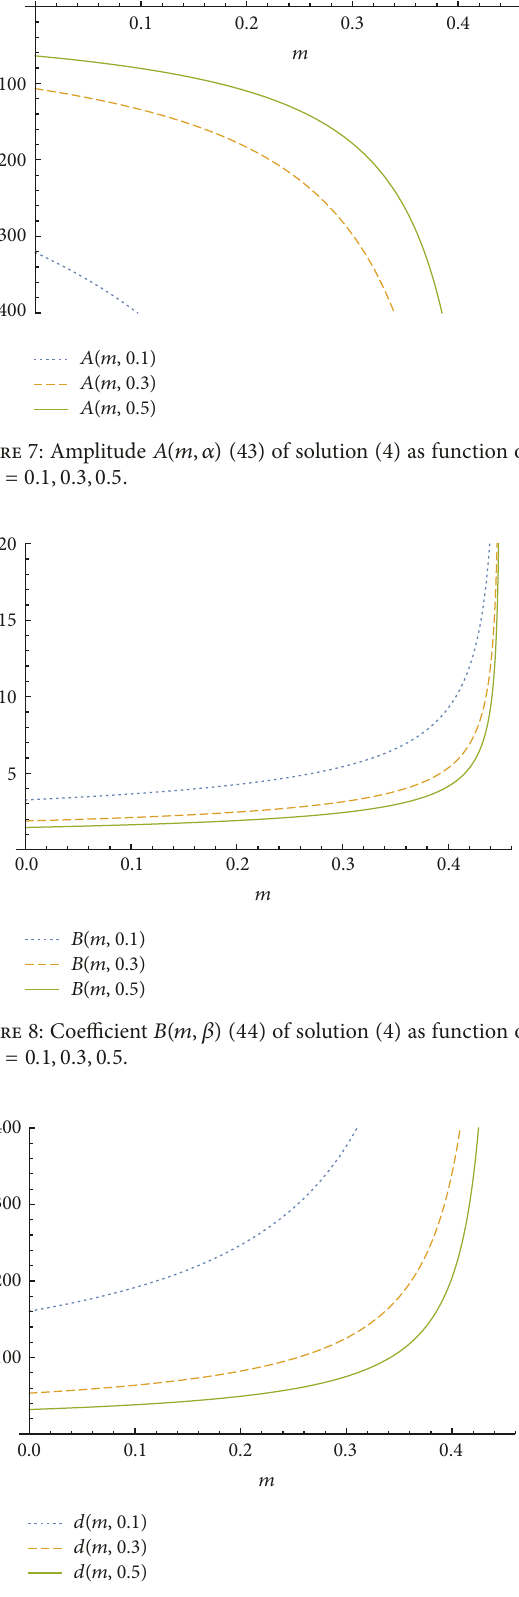
Figure 9: Coefficient 𝐷(𝑚, 𝛼) (45) of solution (4) as function of 𝑚 for 𝛼 = 0.1, 0.3, 0.5